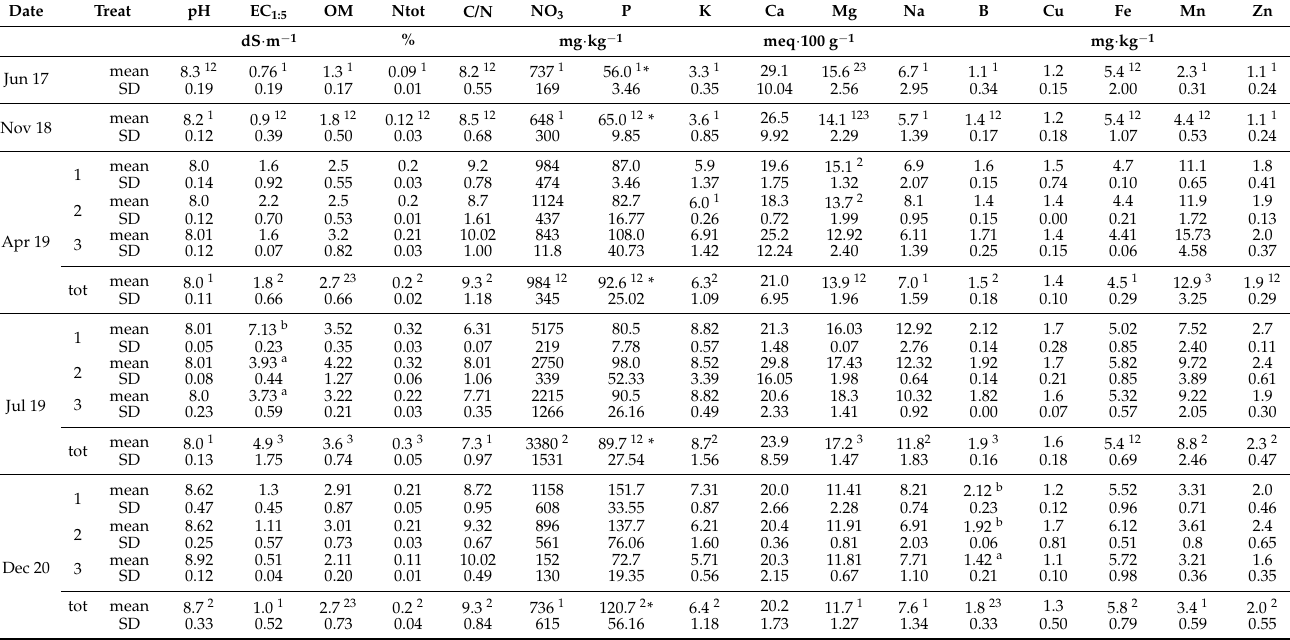
Table 4. Soil properties sampled during the experiment: pre-manure and post-manure applications, seeding day (Apr 2019), first harvest (Jul 2019), and 1 month after the last harvest (Dec 2020) per treatment (1: RWSDI, reclaimed water plus subsurface drip; 2: RWDI, reclaimed water plus surface drip; 3: CWSDI, conventional water plus subsurface drip irrigation, expressed as the mean and SD, standard deviation.